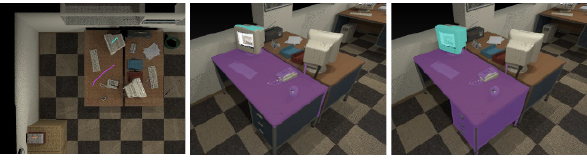
Graph-cut without (middle) and with (right) support relations. Left: input strokes on unsegmented objects in a given